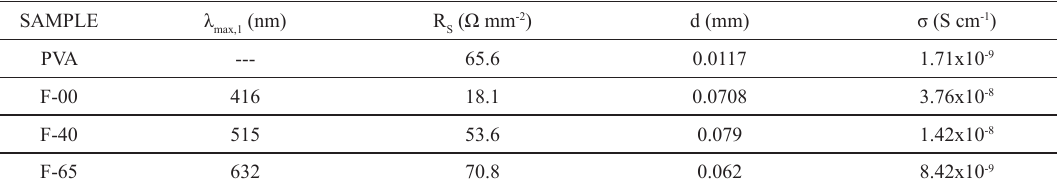
Table 4. Values of σ for films loaded with AgNPs calculated from EIS data.